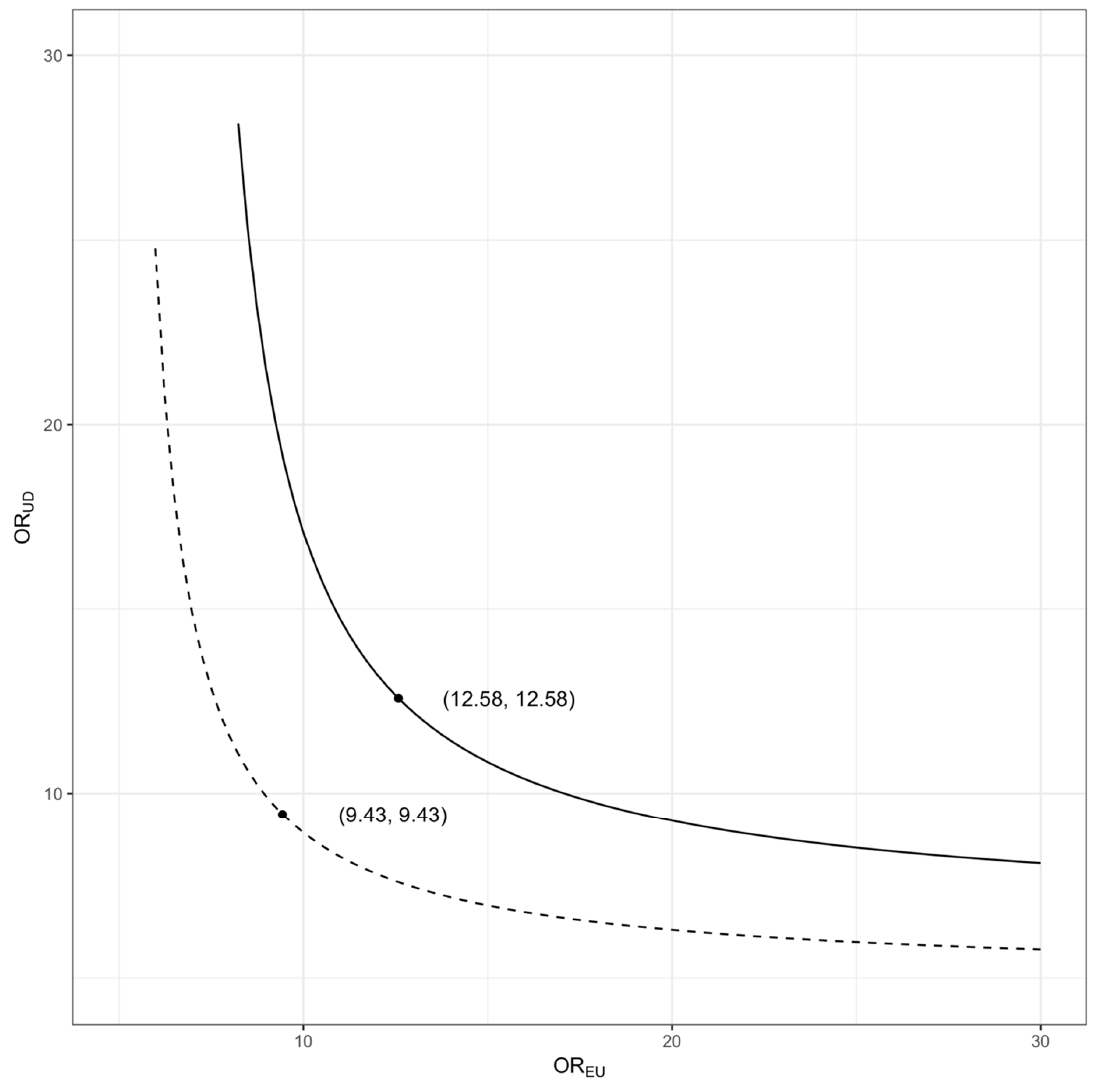
Figure A1. Sensitivity analysis for the association of disposable income and low subjective well-being. The x-axis represents the association of the unmeasured confounder (U) and the exposure (disposable income, E), whilst the y-axis represents the association of the unmeasured confounder (U) and the outcome (low subjective well-being, D). The area above the solid line is the joint values of the E-U and U-D associations that would be required to explain away the observed E-D association (RII = 6.55). The highlighted point on the line represents the strength of either of the E-U or U-D associations has to be bigger than that value in order to explain away the observed E-D association. The dashed line represents that of the lower bound of the 95% confidence interval (4.98). Overall, it means that in the case if either of the E-U or U-D associations has an odds ratio ≥ 9.43, the observed E-D association would be explained away to the